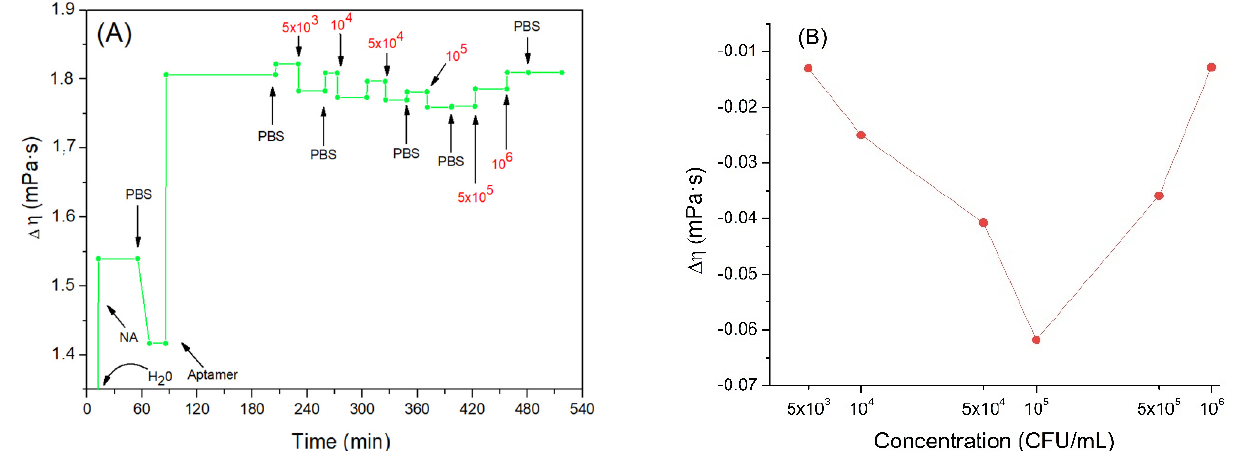
Figure 6. ( A ) the kinetics of the changes of viscosity coefficient (the value of the water viscosity coefficient is not shown in the figure to better highlight the subsequent changes) during formation of the aptamer layer and following addition of Listeria innocua (in CFU/mL). ( B ) Changes in viscosity coefficient depending on applied bacteria concentration in logarithmic scale. Addition of various compounds and washing the surface by water or PBS is shown by arrows.